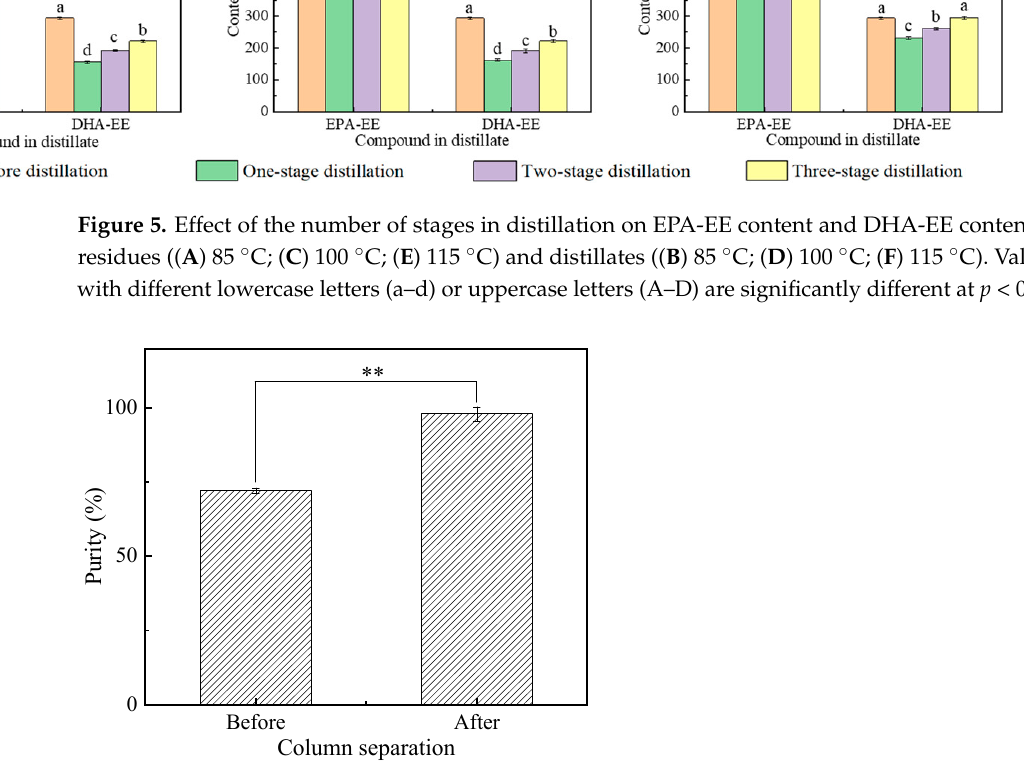
Figure 5. Effect of the number of stages in distillation on EPA-EE content and DHA-EE content in residues (( A ) 85 °C; ( C ) 100 °C; ( E ) 115 °C) and distillates (( B ) 85 °C; ( D ) 100 °C; ( F ) 115 °C). Values with different lowercase letters (a–d) or uppercase letters (A–D) are significantly different at p < 0.05.